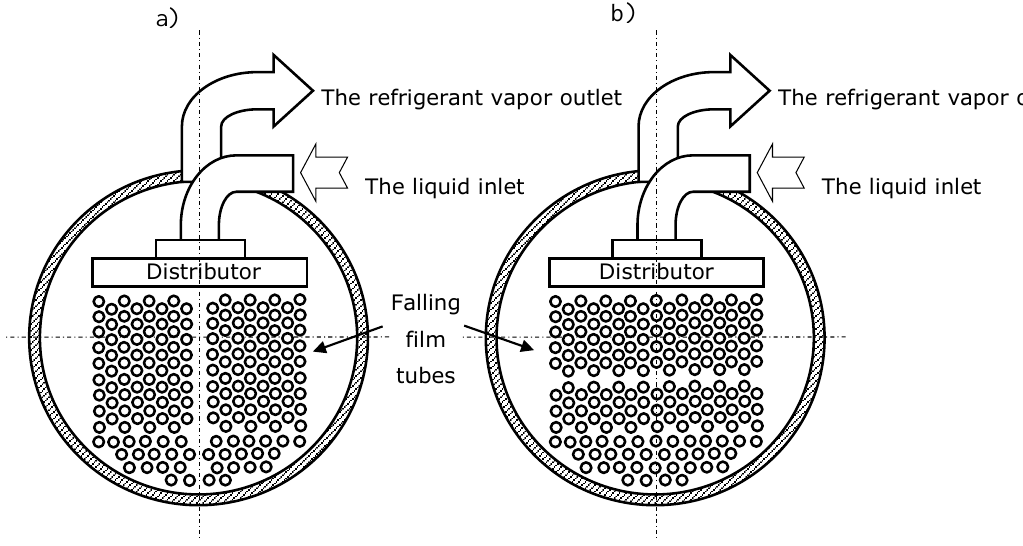
Figure 2. The schematic diagram of the tube pass arrangements of the falling film evaporator, ( a ) side-by-side, ( b ) bottom-to-top and top-to-bottom. Both geometric and operational data are used to develop and validate the model in the